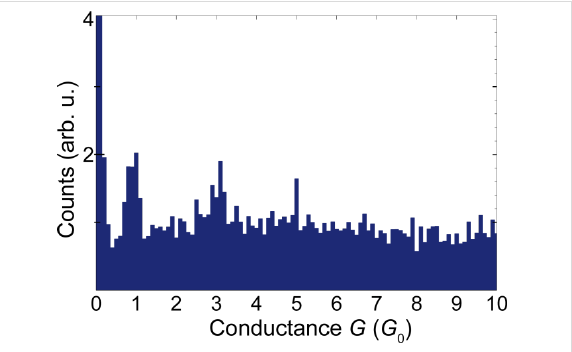
Figure 3: Conductance histogram at 77 K of 220 opening and closing curves recorded with an applied voltage of 5 mV. G 0 = 2 e 2 / h is the conductance